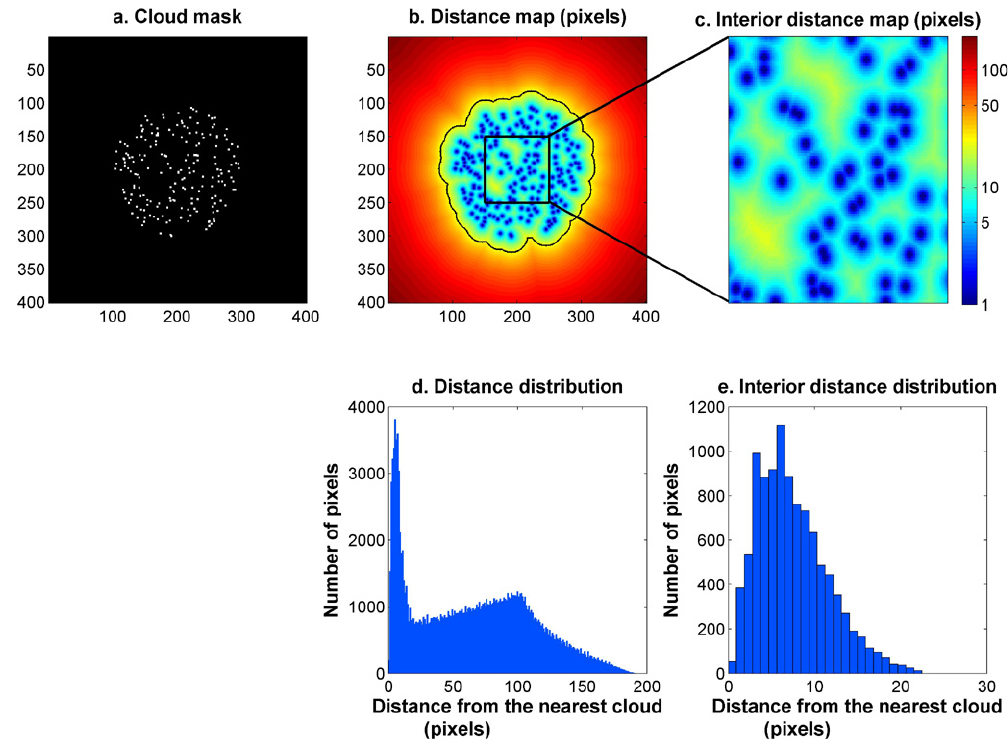
Fig. 1. A synthetic cloud field, containing pixel size randomly distributed clouds (a) , the field’s distance map ( b , logarithmic scale), and a zoom on its interior distance map ( c , logarithmic scale). The different distance distributions of the whole synthetic field and of its interior ( d and e , respectively) enable the detection of the transition point between the intra field distances and the complete field distances. In this case, the transition point appears at r = 22pixels, and its derived cloud field boundary is marked (panel b , black line). The decrease of the distance distribution in panel d (from distances of 100pixels and more) is due to the restricted domain size where larger distances are needed. Note that while Fig. 1c represents a zoomed image of Fig. 1b, the corresponding Fig. 1e represents only an approximated scaled zoom of the interior distances in Fig. 1d (up to ∼ 22pixels), neglecting all distances that describe cloud-free